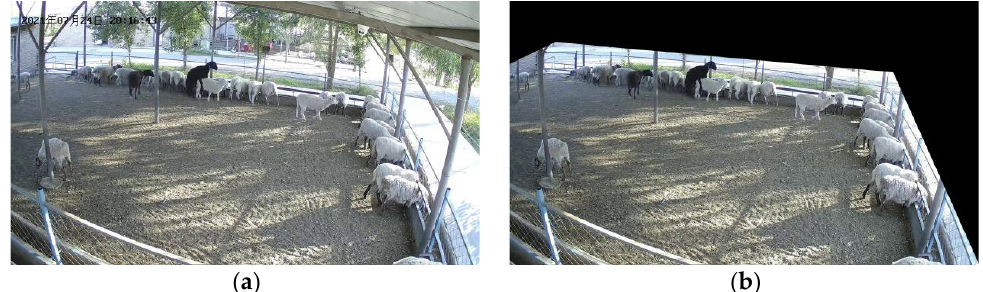
Figure 2. Video image mask operation: ( a ) Image before mask; ( b ) Image after mask. The Chinese characters in the upper left corner of the image are the date of the video recording, in order of year, month, and day.